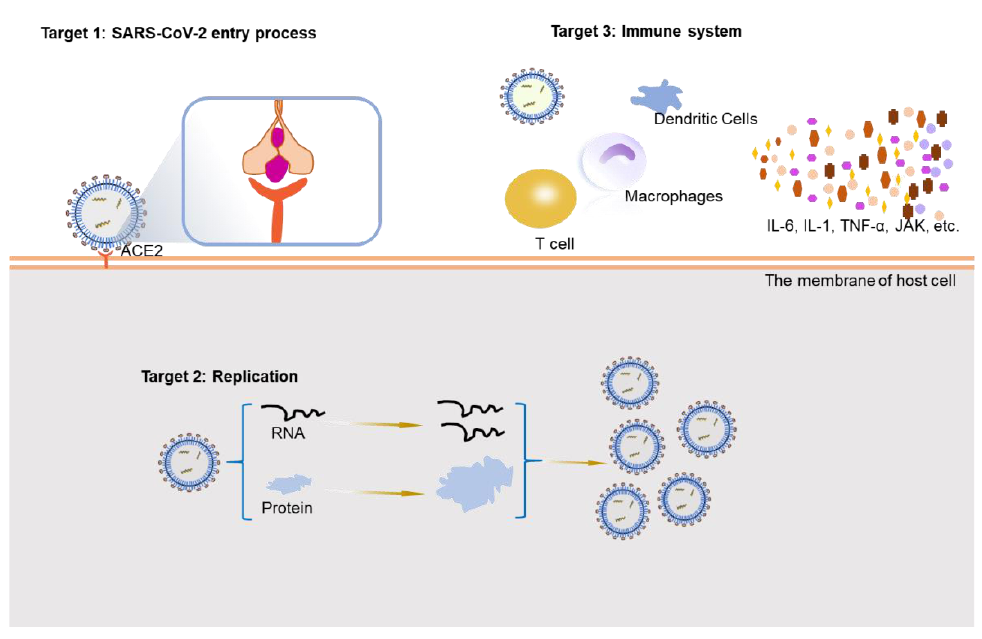
Figure 2. Potential therapeutic targets for the treatment of COVID-19. ACE2: angiotensin-converting enzyme 2; RNA: ribonucleic acid.